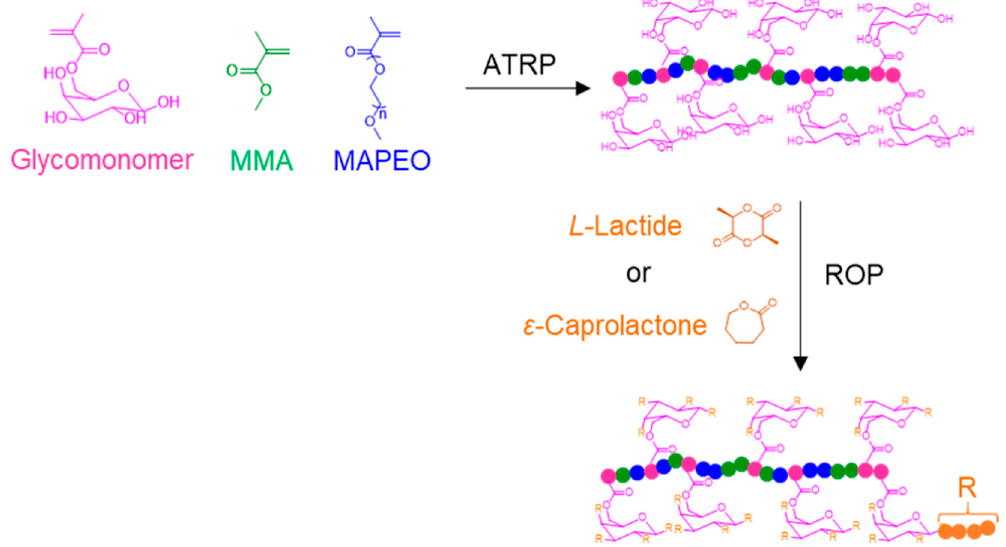
Figure 12. Preparation of a glycol(co)polymer brush by the combination of ATRP and ROP polymerization